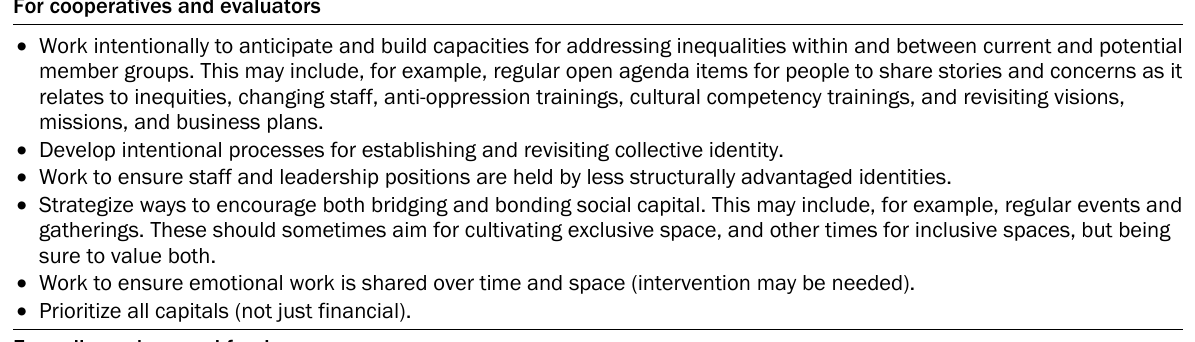
Table 4. Action Steps for Cooperatives to be More Cooperative For cooperatives and